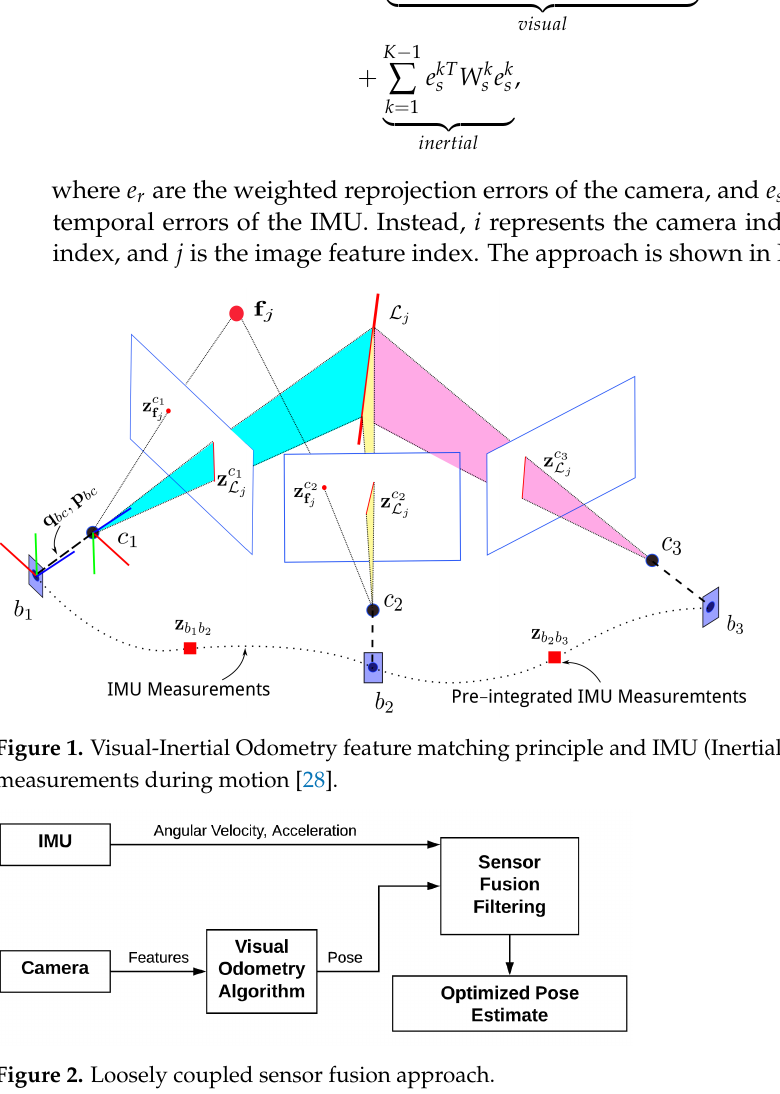
Figure 2. Loosely coupled sensor fusion approach.